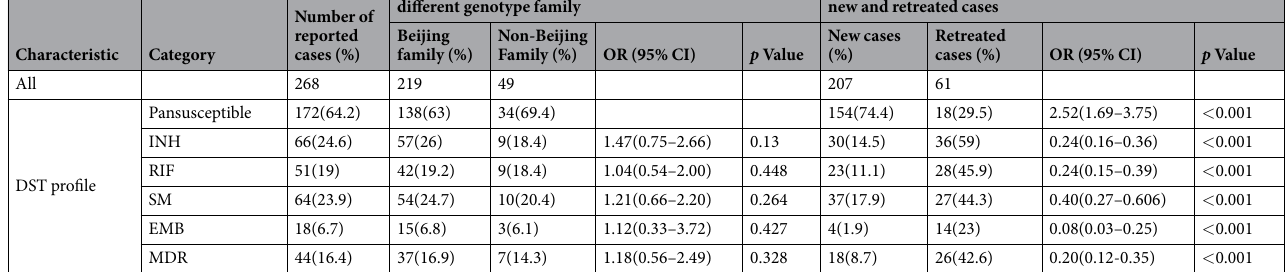
Table 4. The different profiles of drug susceptibility among the different genotype family and different treated cases (n = 268). INH: Isoniazid; RIF: Rifampicin; SM: Streptomycin; EMB: Ethambutol; MDR: multi-drug resistance. p value indicates whether there is a significant difference between Beijing family and non-Beijing family ( p < 0.05 represents a statistically significant difference).